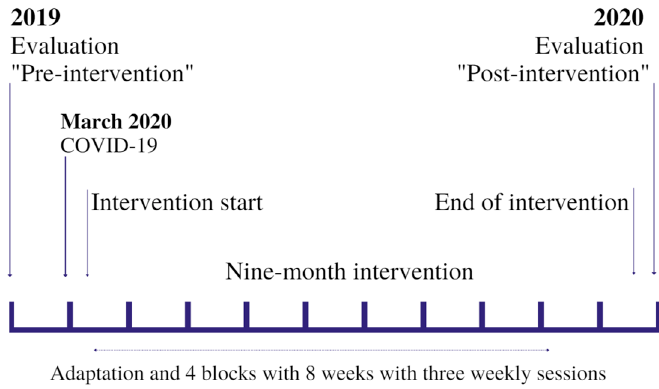
Figure 2. Study timeline with emphasis on evaluation moments.